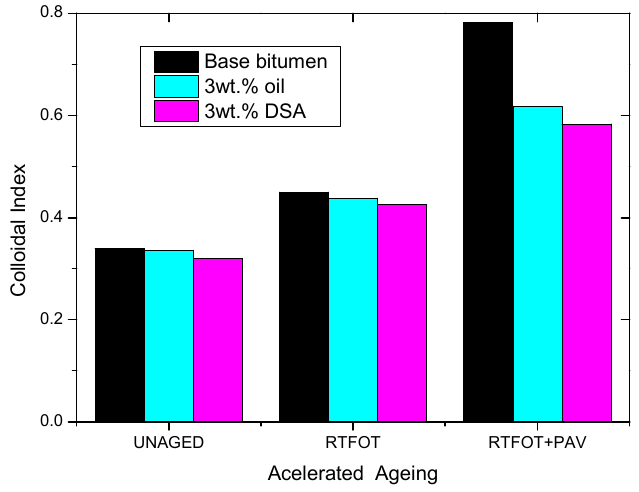
Figure 10. Colloidal Index values for neat and modified bitumen after RTFOT + PAV.